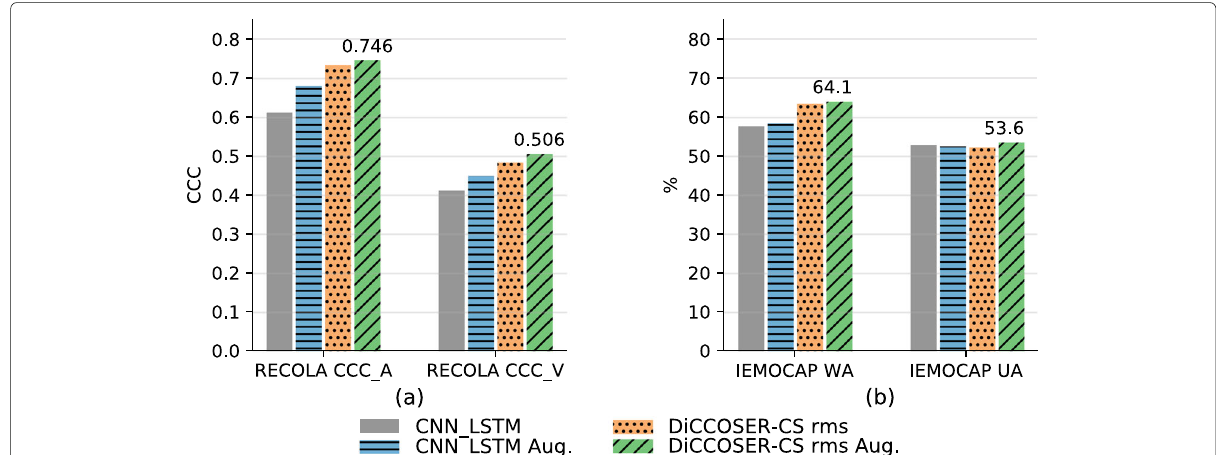
Fig. 6 Performance comparisons to the baseline CNN-LSTM model. “Aug.” indicates using the sliding window augmentation in a or the random flipping augmentation in b